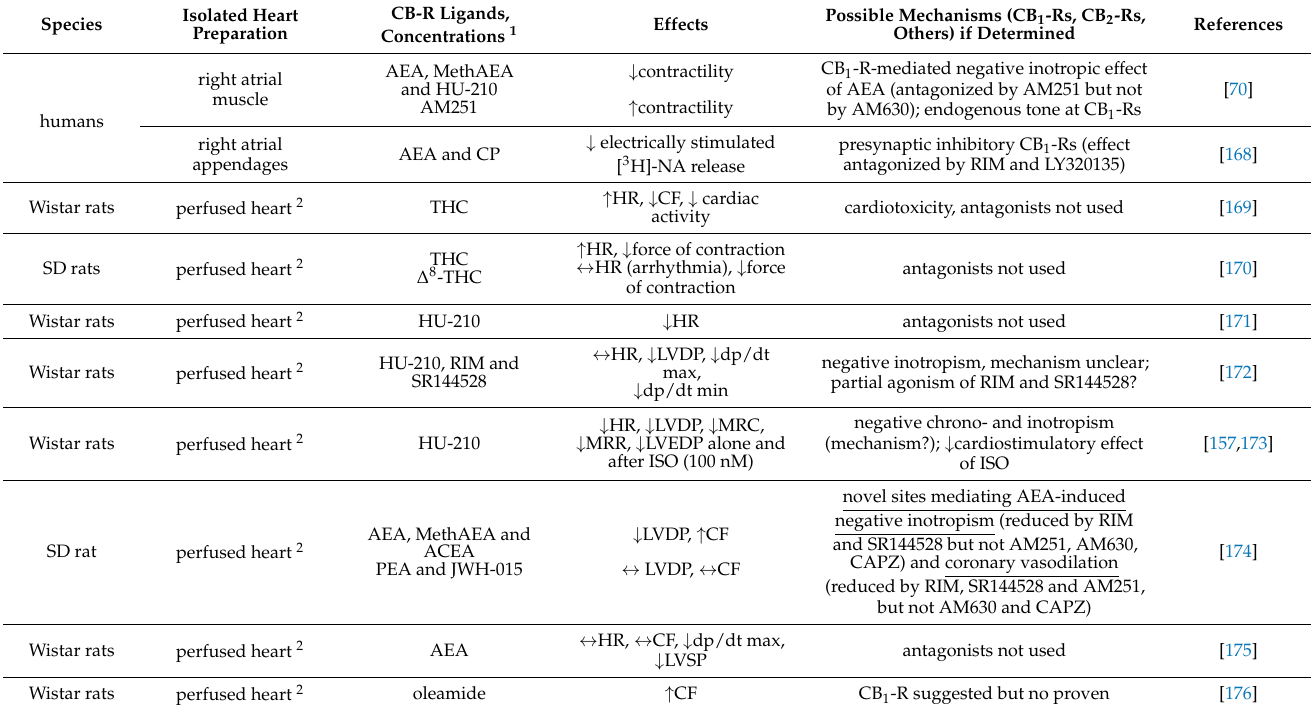
Table 4. Effects of cannabinoid-receptor agonists on heart preparations and platelets of humans and experimental animals in